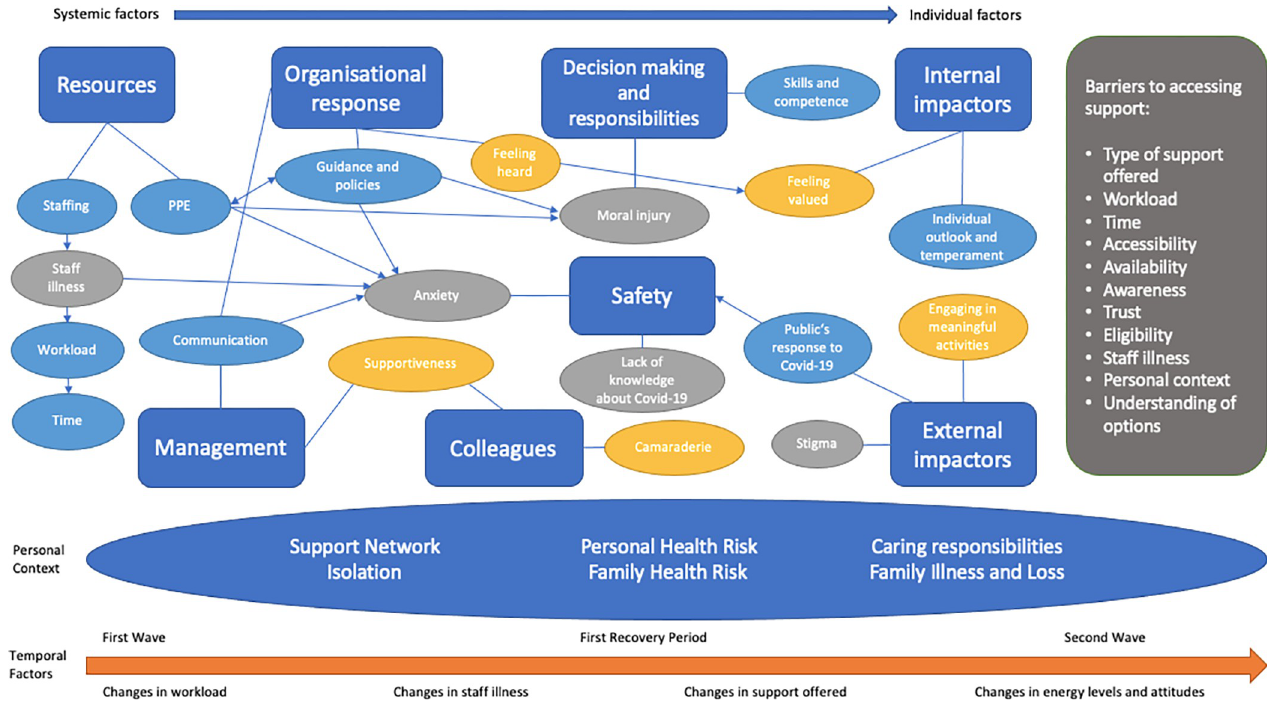
Fig 1. Theoretical model of the factors that helped and hindered coping experiences of health and social care professionals working during the Covid-19 pandemic.